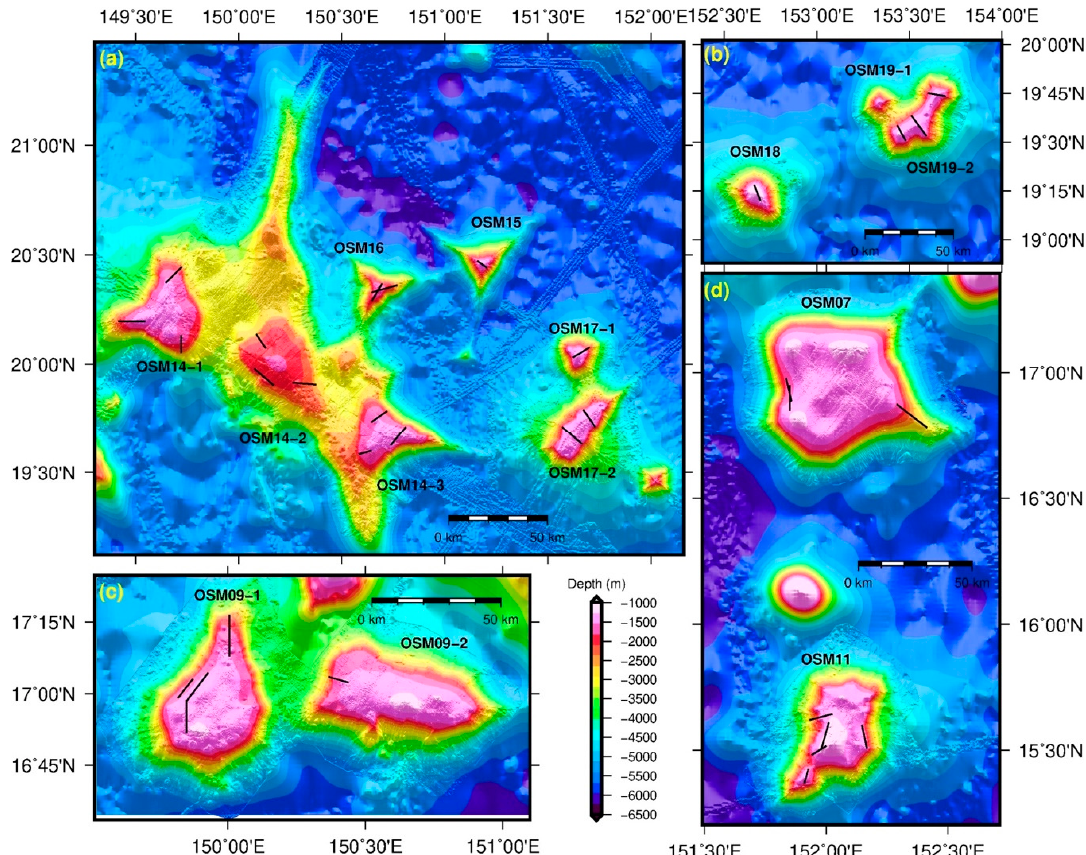
Figure 2. Multibeam-derived bathymetry shadow-relief maps of seamounts in the ( a ) northwest (OSM 14, OSM 15, OSM 16, and OSM 17), ( b ) northeast (OSM 18 and OSM 19), ( c ) southwest (OSM 9), and ( d ) south sectors (OSM 7 and OSM 11) of Figure 1b. Black lines are the transects of the deep-sea camera system (DCS) survey locations.